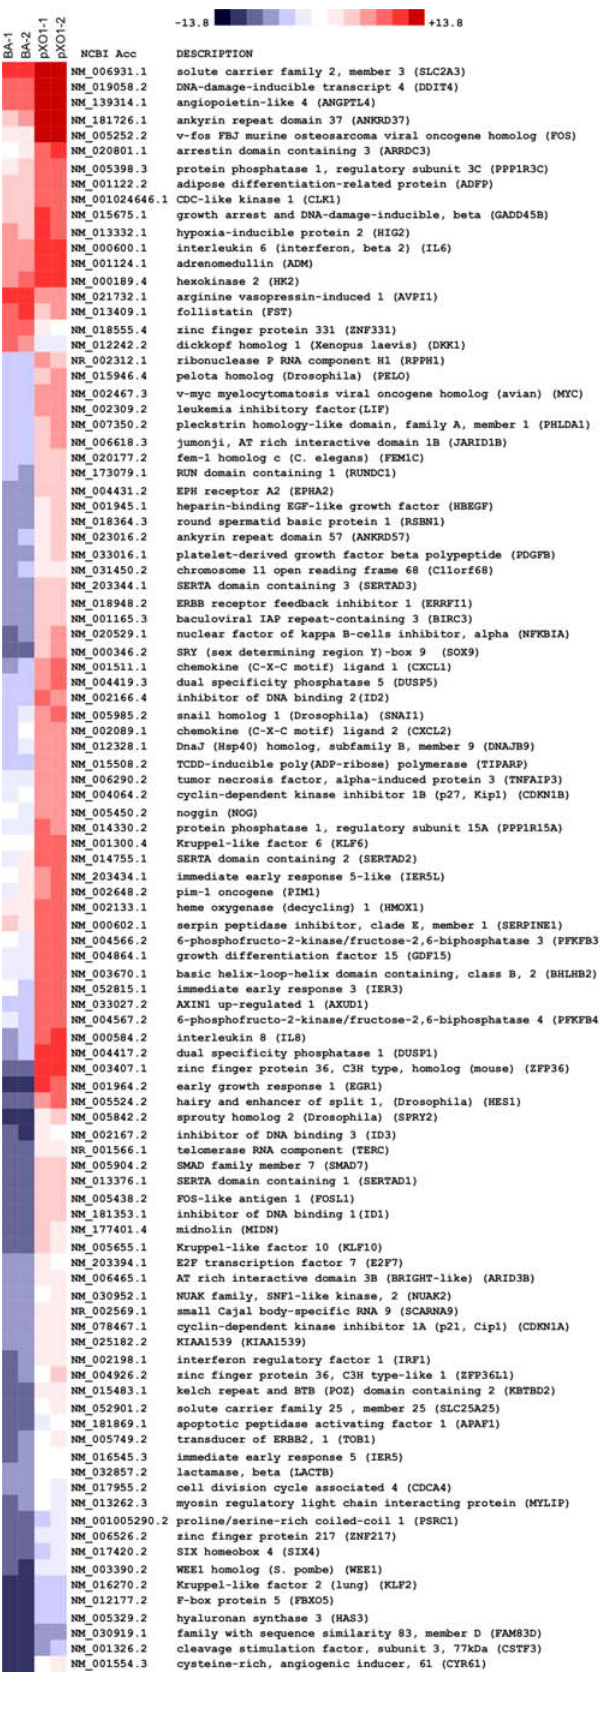
Figure 4. Heatmap identifying genes with 2.2 fold differential expression levels in hBMEC upon infection with B. anthracis Sterne vs. D pXO1 mutant strain. Each column represents a biological replicate microarray experiment upon infection with B. anthracis Sterne (BA) or D pXO1 bacteria (pXO1). Red and Blue coloring indicates induced or downregulated gene expression levels, respec- tively, of infected hBMEC vs. media control. Expression clustering was performed based on pairwise similarity, as described in Material and Methods.